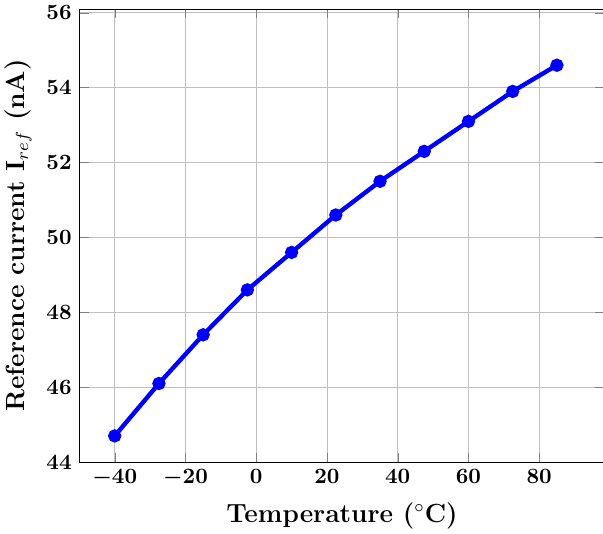
Figure 3. Post layout simulation result of reference current obtained from RBM